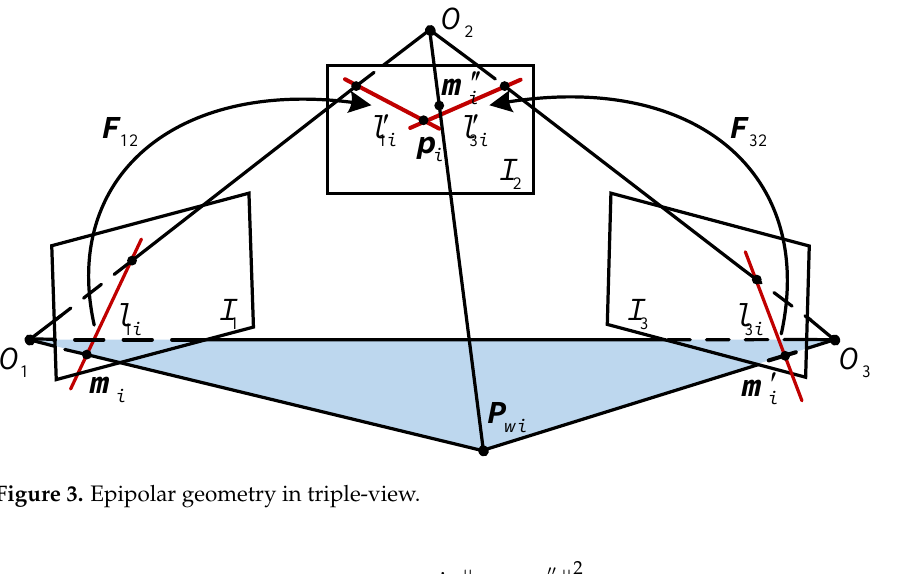
Figure 3. Epipolar geometry in triple-view.